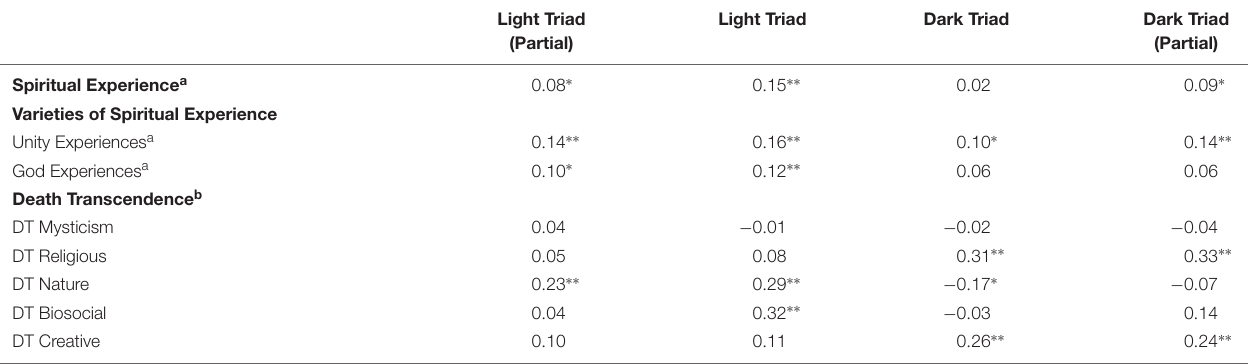
Light Triad Light Triad Dark Triad Dark Triad (Partial) (Partial)